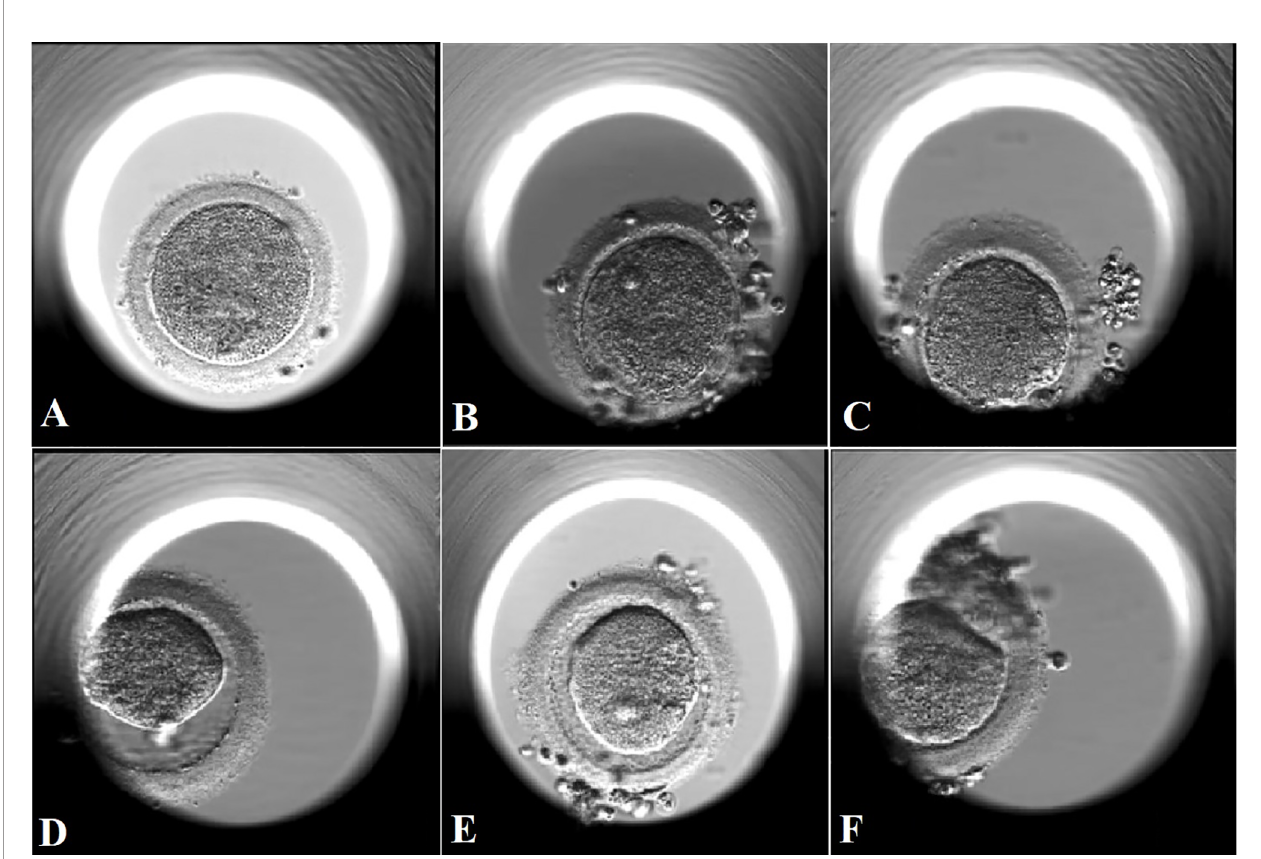
FIGURE 4 | Ampli fi ed images of degenerated oocytes on Day 1 with different oocyte degeneration rates (ODR: 0, <10%, 10-20%, and >20%). (A) : ampli fi ed image of a degenerated oocyte in subgroup with ODR<10% in (B) . The oocyte was degenerated immediately after withdrawal of the injection needle, coexisting with sudden breakage upon needle entry and leakage of cytoplasm which led to the absence of PVS. (B, C) : ampli fi ed images of degenerated oocytes in subgroup with ODR 10-20% in (C) . (D, F) : ampli fi ed images of degenerated oocytes in in subgroup with ODR>20% in (D) . These oocytes were degenerated within a few hours after ICSI manipulation with shrank and darkened ooplasm.